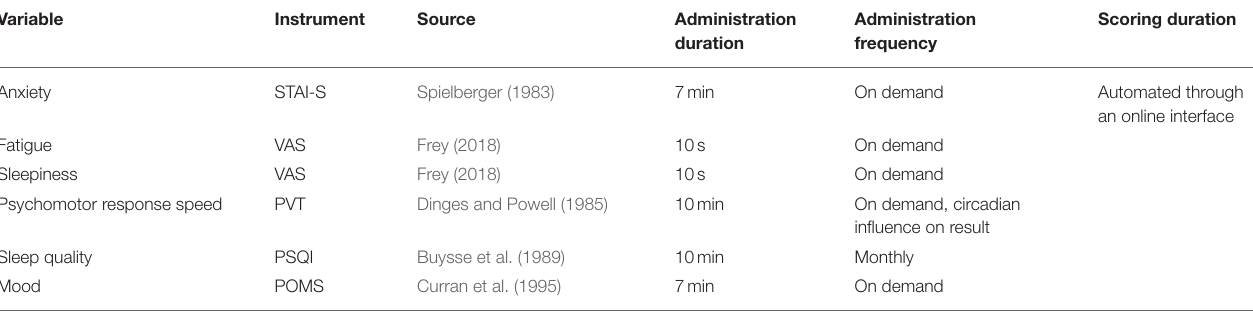
TABLE 3 | Summary of the psychometry tools used for the psychological mapping of selected state variables to allow for self-monitoring.